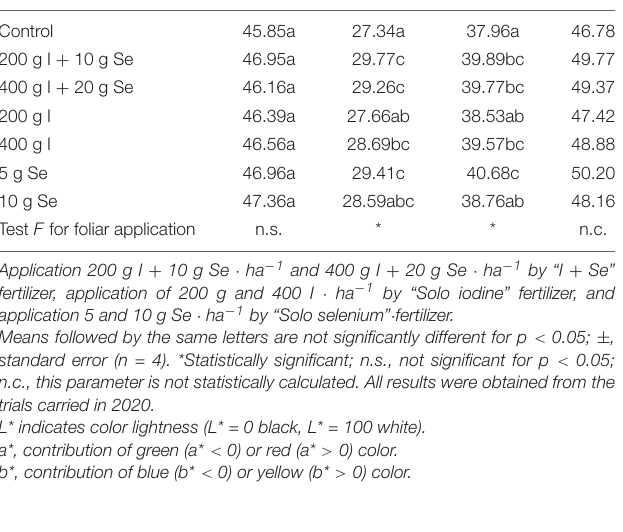
TABLE 9 | Color parameters of carrot storage roots, depending on the foliar application of iodine and selenium–results only from 1 year of study. Foliar